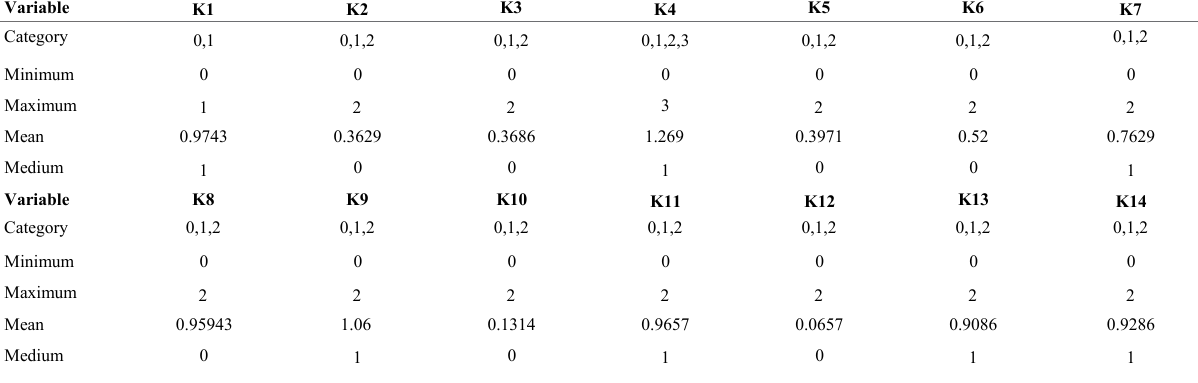
TABLE 3 A partial description of statistics for 14 variables.